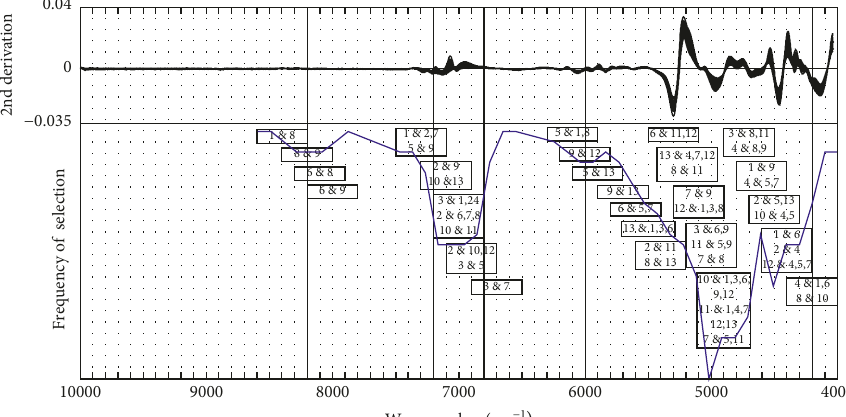
Figure 5: Location of the selected regions by L-VS based on the SIMCA classification method. L-VS: local variable selection; SIMCA: soft independent modelling of class analogy.